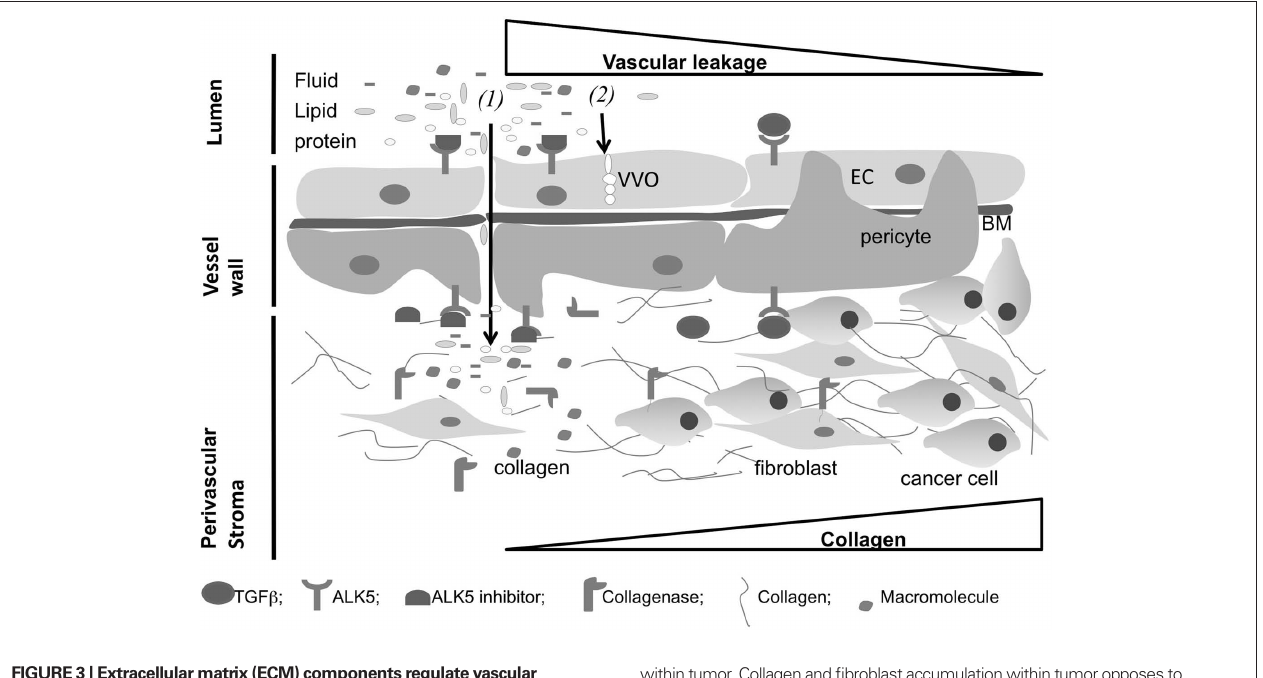
within tumor. Collagen and fibroblast accumulation within tumor opposes to macromolecule penetration and reduces drug delivery. Collagen metabolism by collagenases results in increased vascular leakage and accumulation of macromolecules within tumors. Short inhibition of TGF β signaling in vascular wall and control of the ECM metabolism in perivascular stroma could enhance drug delivery in solid tumors (EC, endothelial cell; BM,